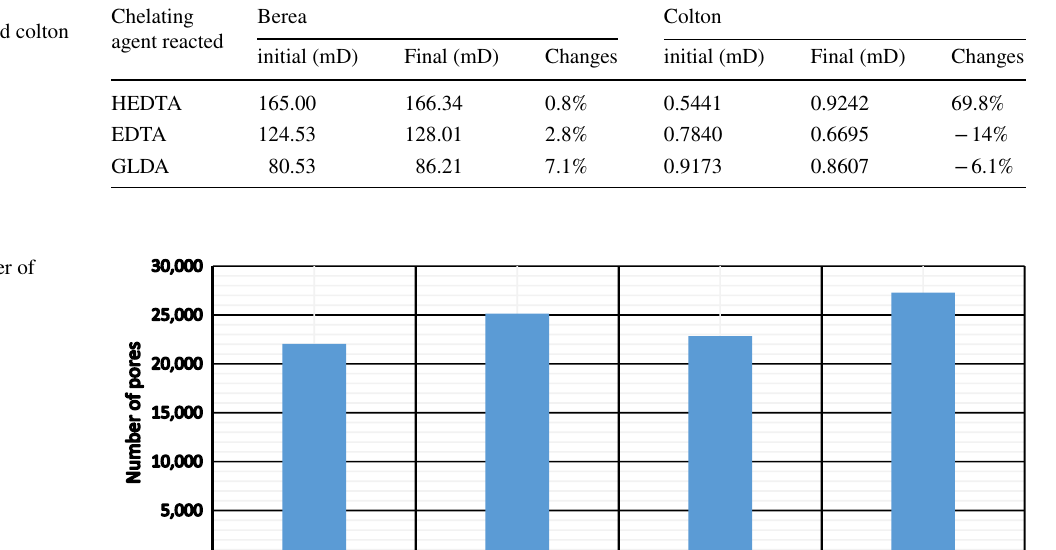
permeability of berea and colton sandstone